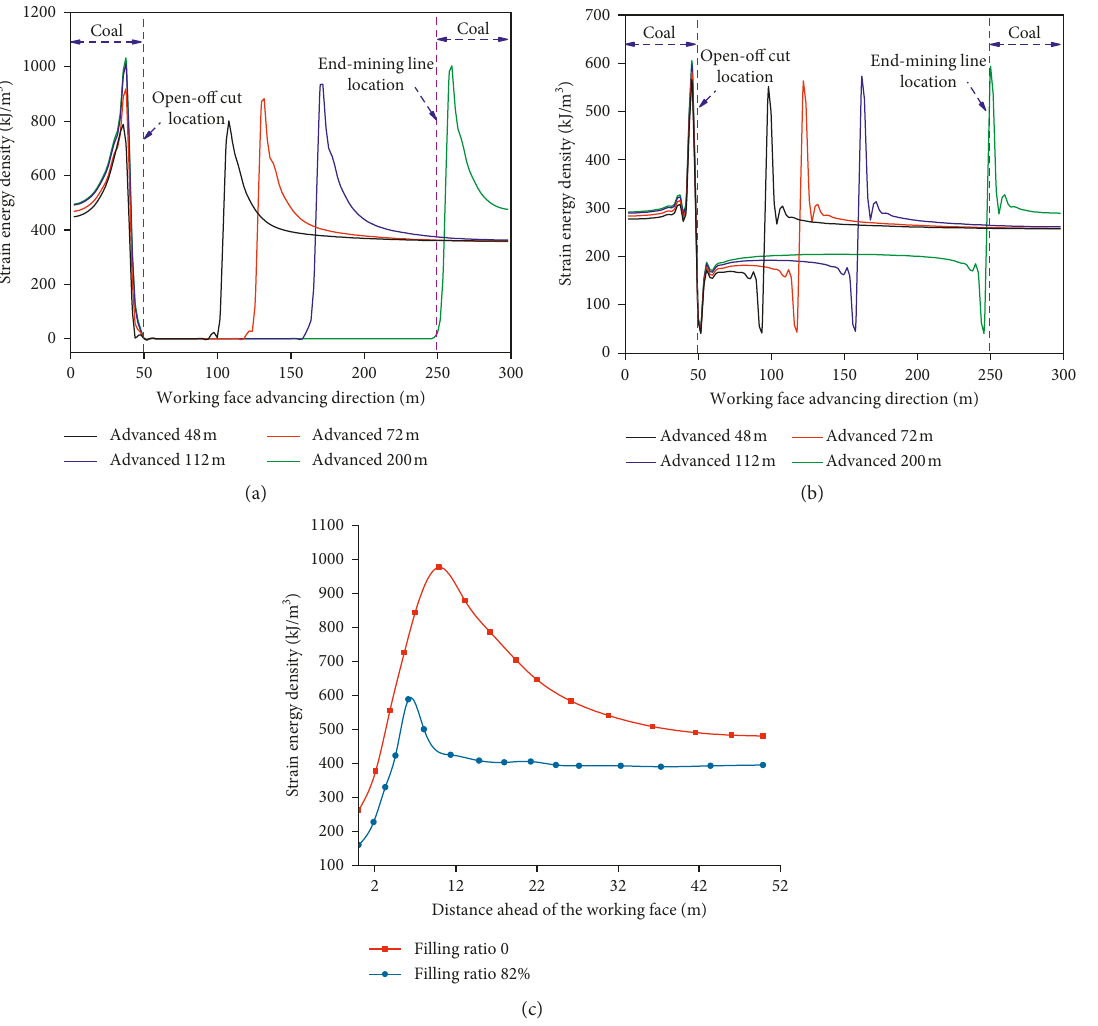
Figure 9: Strain energy density distribution along the central axial direction of working face. (a) Caving method. (b) Backfilling method. (c) Advancing distance of